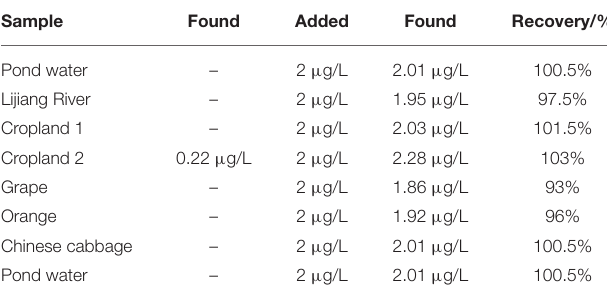
TABLE 3 | Sample analysis results ( n =